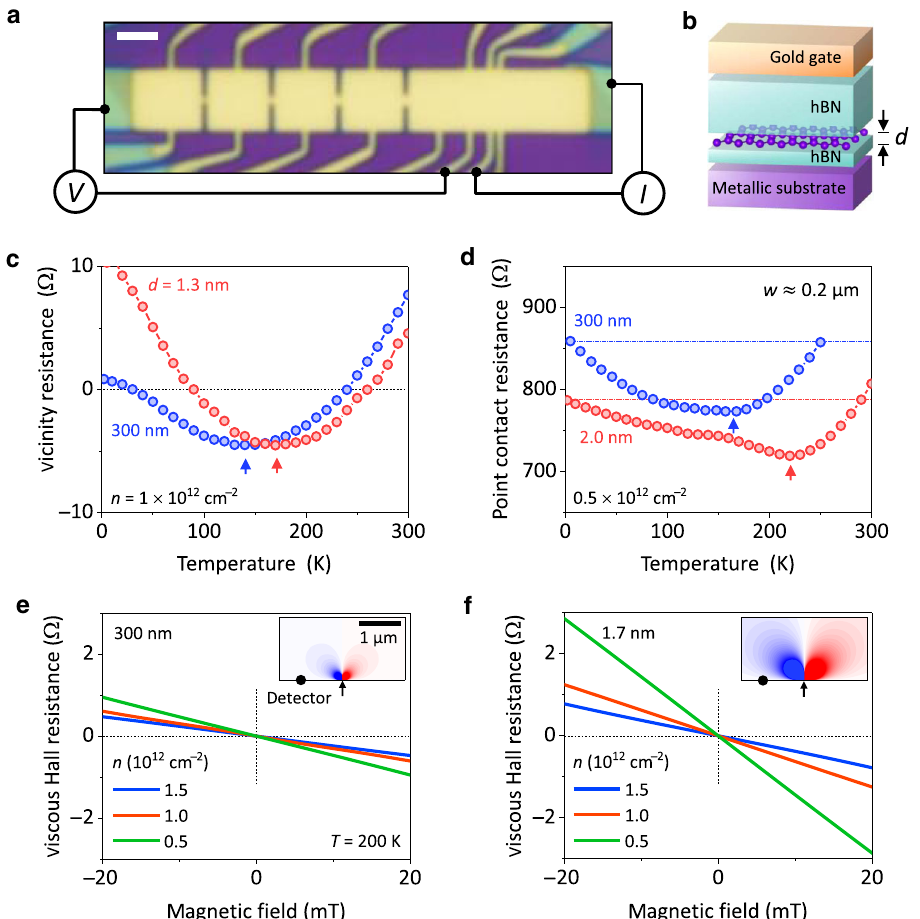
Fig. 1 Graphene devices with proximity gating and its effect on electron hydrodynamics. a Optical micrograph of one of our devices with four sub- μ m constrictions used for point-contact measurements and several closely spaced contacts for vicinity measurements. The wiring schematic illustrates current and voltage con fi gurations for the latter measurements. Scale bar, 2 μ m b Schematic side view of our heterostructures. c R as a function of T for V representative devices with a close graphite gate ( d (cid:3) 1 : 3 nm , red) and in the reference geometry ( d ¼ 300 nm , blue). The devices had similar geometry ð T Þ for screened and reference constrictions of the same width w (cid:3) 0 : 2 μ m (same color coding as in c ). Dashed lines in and μ ; same L = 0.5 μ m. d R PC and R . e , f Viscous Hall effect for reference and close-gate devices d denote the resistance in the ballistic limit. Arrows in c and d indicate minima in R V PC ( d ¼ 300 and 1 : 7 nm ; respectively). The color-coded curves correspond to different n ; all measurement conditions and geometries were same, including L ¼ 1 μ m and T ¼ 200 K . The insets illustrate electric potentials that appear due to a viscous electron fl ow (the arrow and circle indicate positions of (cid:3) 0 : 3 and 0 : 8 μ m for panels e and current and voltage contacts, respectively). The calculations 17 were carried out for the experimentally determined ‘ ee f , respectively; B ¼ 10 mT . Blue-to-red color scale is arbitrary but same for